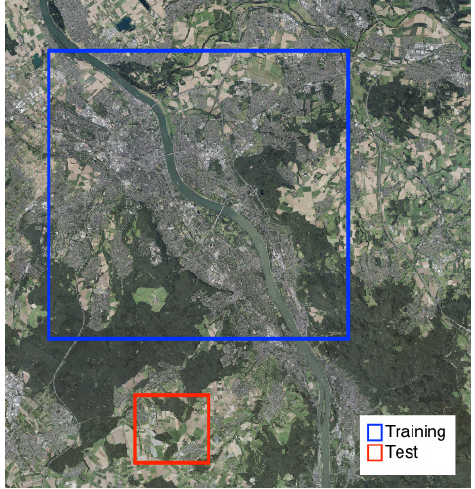
Figure 2. Aerial footage that is used for training and evaluating the image segmenter The images are taken by a downward looking